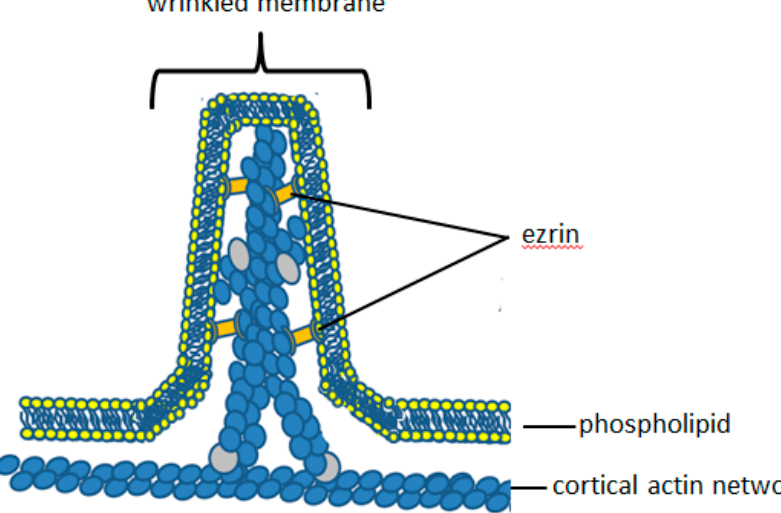
Figure 3. The molecular anatomy of the neutrophil cell surface wrinkles. The relative locations of ezrin (within the wrinkles) and the cortical actin network are shown. As in Figure 3, the ezrin crosslinks polymerised actin to the plasma membrane and prevents the operation of the Brownian ratchet, which drives actin polymerisation to push out the plasma membrane. The wrinkle is consequently a stable structure on the cell surface, which is little affected by Brownian effects.